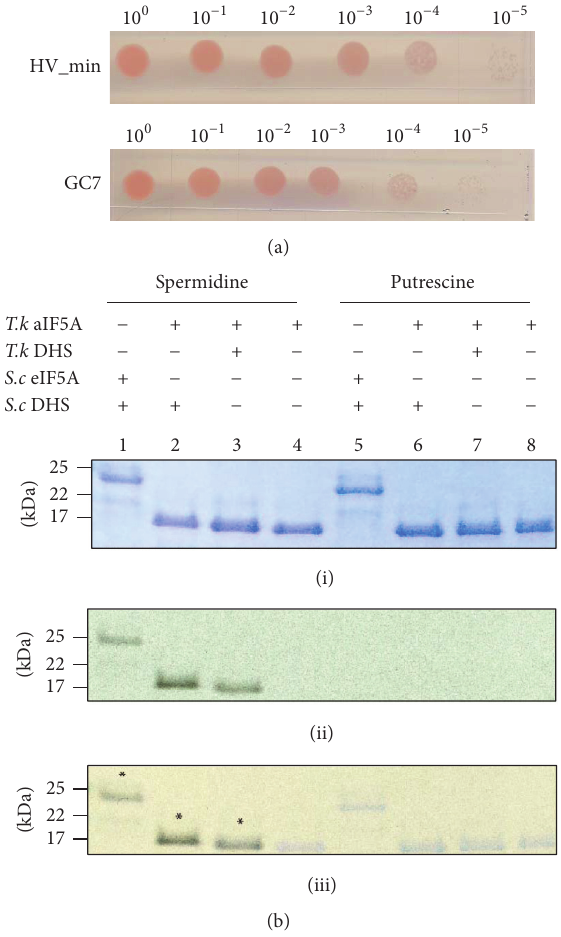
Figure 6: Hfx. volcanii is insensitive to GC7 and spermidine is the substrate of T. kodakarensis DHS. (a) Effect of GC7 on the growth of H26. Hfx. volcanii H26 (WT, parent) was diluted to OD 600 of 1 and then spot-plated (15 𝜇 L) on solid agar Hv min medium in serial dilutions as indicated in absence or in presence of 1mM GC7. Each experiment was performed with two biological replicates and three technical replicates. (b) Detection of T. kodakarensis aIF5A (lanes 2, 3, 4, 6, 7, and 8) and S. cerevisiae eIF5A (lanes 1 and 5) modification using [ 14 C] spermidine or [ 3 H] putrescine as substrates in presence of T. kodakarensis DHS (lanes 3 and 7) or S. cerevisiae DHS (lanes 1, 2, and 5). The in vitro assay was resolved on a 16.5% tricine polyacrylamide gel. The dried gels were exposed to autoradiography films to visualize possible modifications. The assembly of each reactionisdepictedabove.(i),CoomassieBluestaining;(ii),exposed autoradiography film; (iii), overlay of the CoomassieBlue stained gel and the exposed film; ∗ indicates the presence of the radioactivity; molecular mass markers are indicated in kDa; T.k , Thermococcus kodakarensis ; S.c , Saccharomyces cerevisiae .